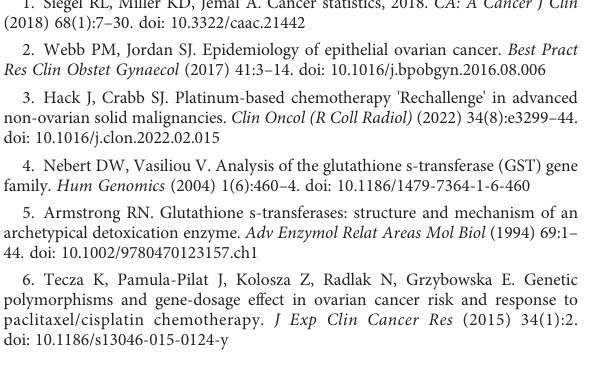
SUPPLEMENTARY FIGURE 1 The regulatory mechanisms of GSTM members. (A) The DNA m5C methylation level of GSTM1-5 in OC patients and normal women. (B) The miRNA network of GSTMs based on GSCALite database. SUPPLEMENTARY FIGURE 2 The protein structure of GSTM members. SUPPLEMENTARY FIGURE 3 Theexpression distributionofGSTM1-5immunescore inOCsamplesand normal ovary samples. Immune cell score heatmap for GSTM1 (A) , GSTM2 (C) , GSTM3 (E) , GSTM4 (G) and GSTM5 (I) based on TCGA database via the Wilcox test. The percentage abundance of OC in fi ltrating immune cells in GSTM1 (B) , GSTM2 (D) , GSTM3 (F) , GSTM4 (H) and GSTM5 (J) group. Different colors indicated different immune cells types. The abscissa represents the OC sample, and the ordinate represents the percentage of immune cell content in each OC sample. *p < 0.05; **p < 0.01; ***p <